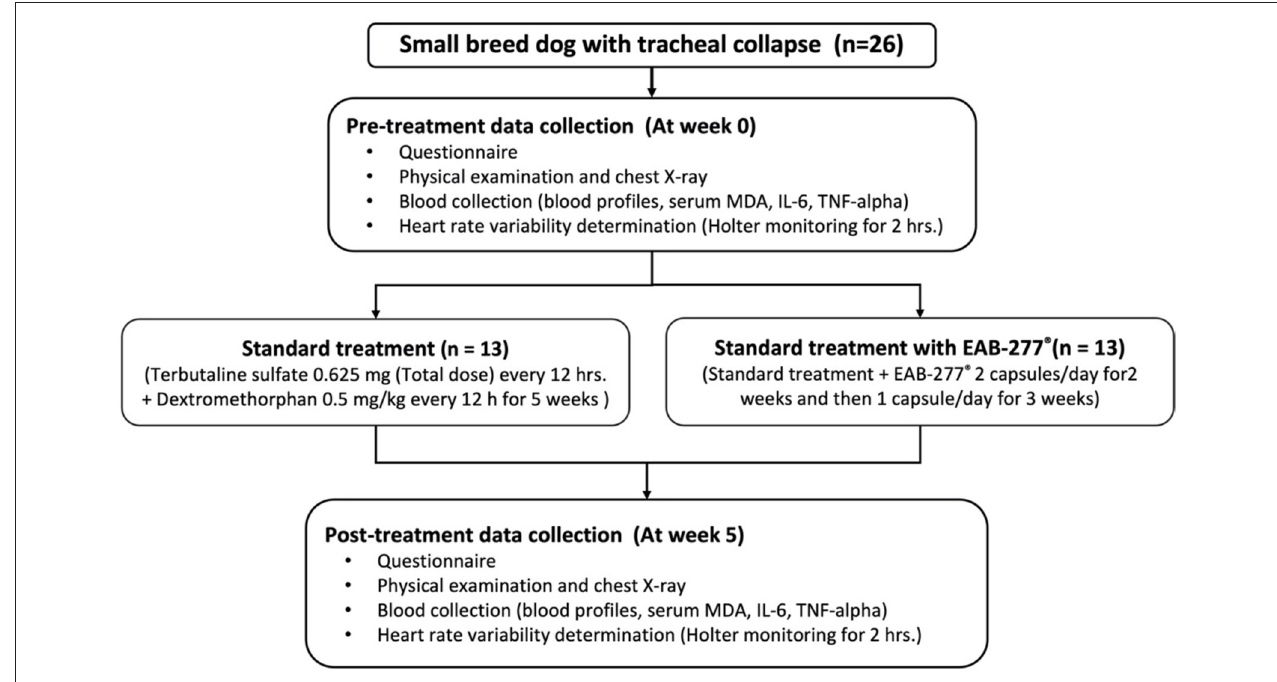
FIGURE 1 | Schematic representation of the study protocol. At pre-treatment, all dogs underwent chest X-ray, blood collection, Holter recording for 2-h. Then, dogs were divided into two groups to receive the standard treatment or standard treatment combined with polyunsaturated fatty acid EAB-277 ® from Green-Lipped Mussel blend for the 5 weeks. At post-treatment, all dogs underwent the re-assessment of chest X-ray, blood collection, Holter recording for 2-h to investigate cardiac sympathovagal balance, plasma oxidative stress, and inflammatory marker measurement. MDA,